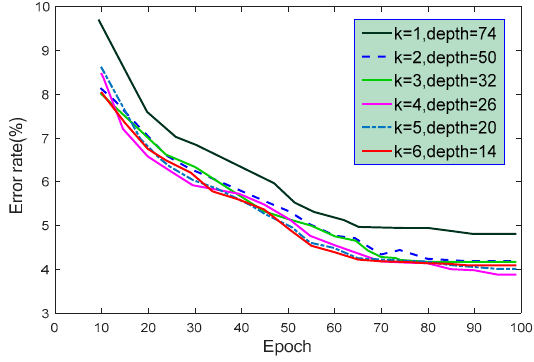
Figure 9. The curve for the training times and the error rates for the test set.